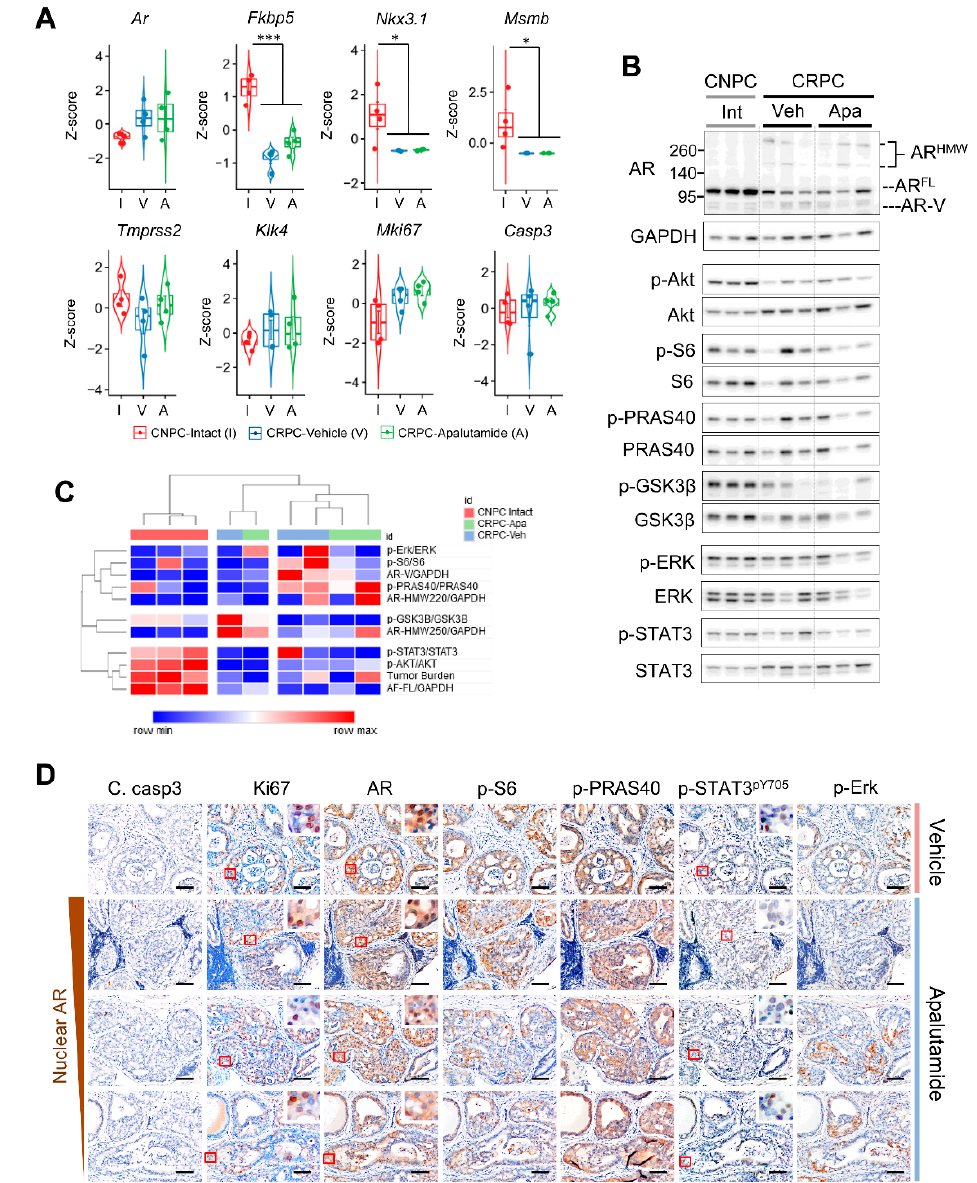
Figure 4. Profiling the molecular responses to apalutamide therapy in Pten -deficient castration-resistant prostate cancer (CRPC). Molecular responses to apalutamide therapy were determined by comparing the marker molecules of androgen receptor (AR) and prostate cancer cell survival signaling by qRT-PCR, Western blot and immunohistochemistry (IHC) in intact (Int) castration-naïve prostate cancer (CNPC) and CRPC after four weeks of treatment with the vehicle (Veh) or apalutamide (Apa, 30 mg/kg, p.o. 5 times/week). ( A ) qRT-PCR comparison of the mRNA of the Ar and AR target genes in intact CNPC (I) and CRPC treated with the vehicle (V) or apalutamide (A); n = 4 mice/group. Significance calculated by the Student–Newman–Keuls post-hoc test for individual comparisons, upon a significant one-way ANOVA (* p < 0.05 and *** p < 0.001). ( B ) Western blots of full-length AR (AR-FL), AR splicing variant (AR-V), AR high-molecular weight (AR-HMW) and the signaling molecules associated with PI3K/AKT, MAPK and STAT3 signaling in intact CNPC (Int) and CRPC treated with the vehicle (Veh) or apalutamide (Apa); n = 3 mice/group. Samples were collected four hours after the last treatment dose. Semiquantitative densitometric analysis was performed in ImageJ; the proteins were first normalized to GAPDH and phosphorylated proteins were normalized to total protein. ( C ) Heatmap and unsupervised hierarchical clustering of the z-score-transformed data of the semiquantitative Western blot data and tumor burden using average linkage and Euclidean